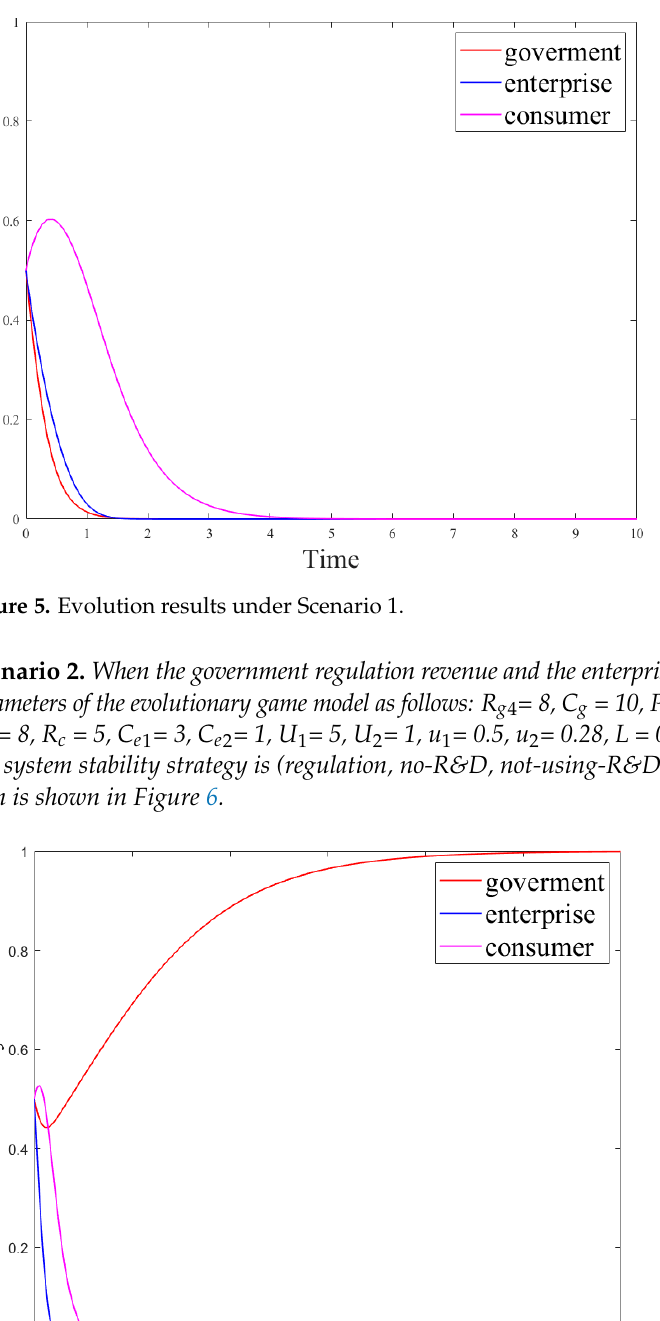
Figure 6. Evolution results under Scenario 2.